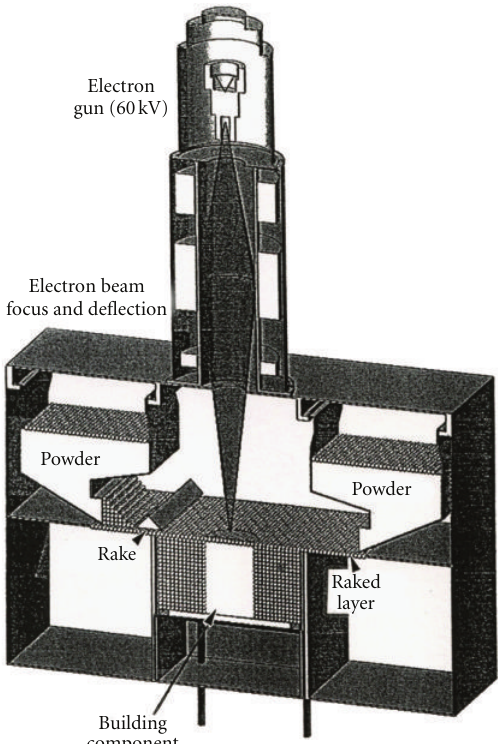
Figure 1: Schematic view of the Arcam A2 electron beam melting (EBM) system.